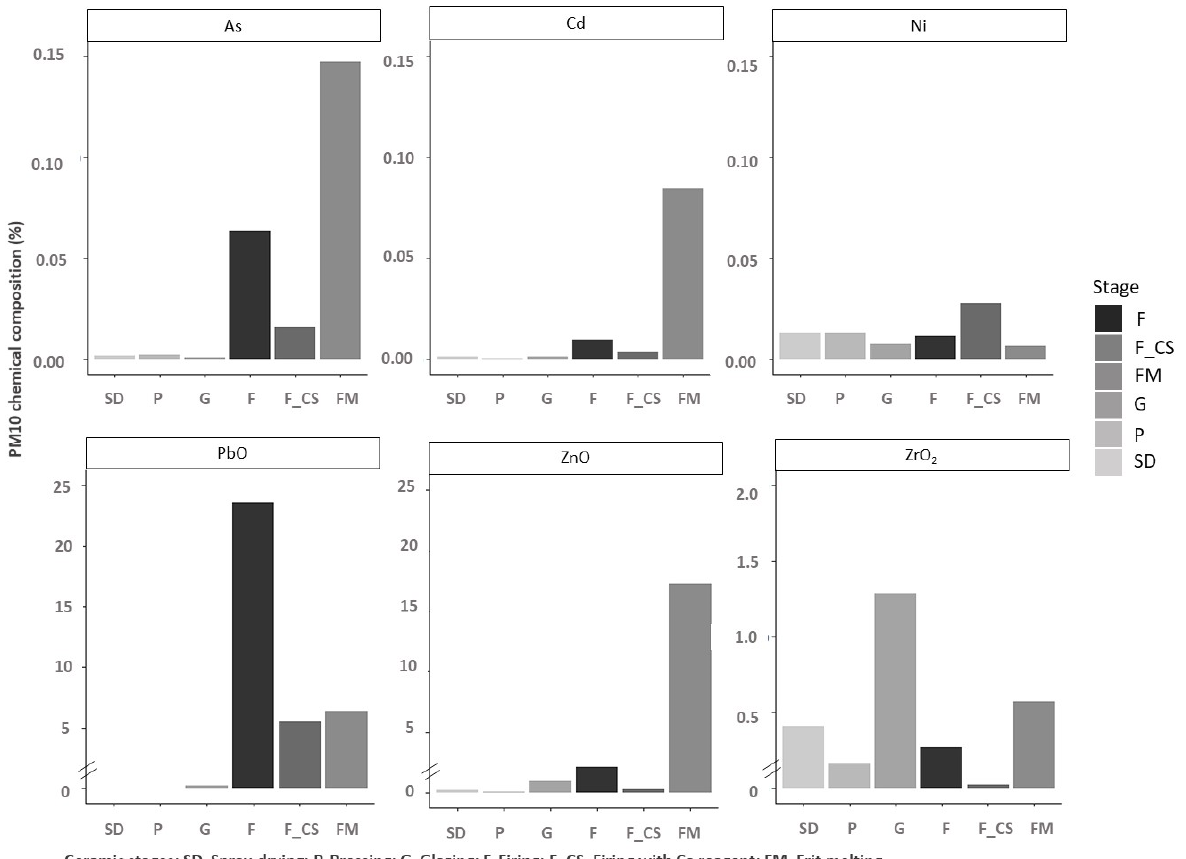
Figure 6. PM 10 composition in the different stages of the ceramic process.